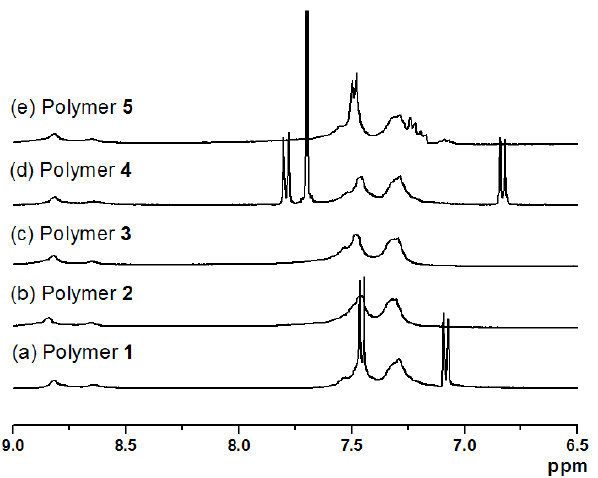
Figure 1. Expanded 1 H NMR spectra of polymers 1 − 5 (10 mg/mL in d 6 -DMSO at 25 °C).